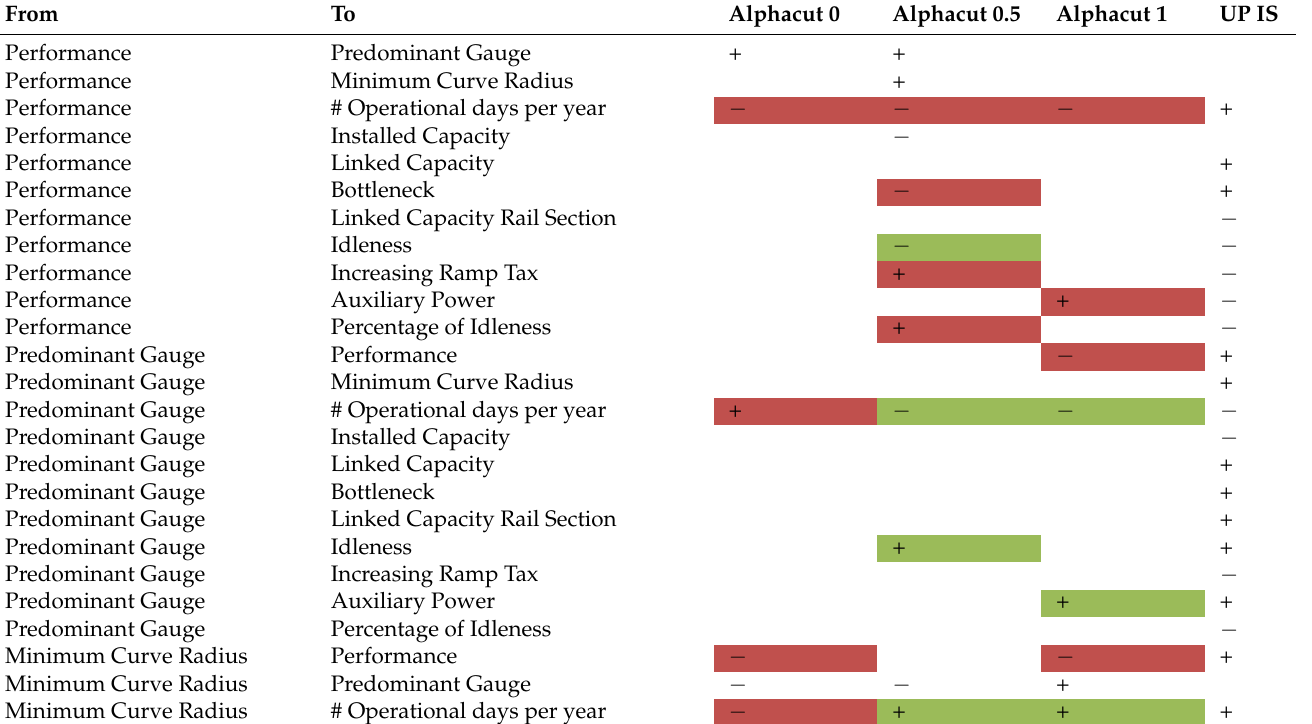
Table A1. Results comparison between UP-IS and Fuzzy